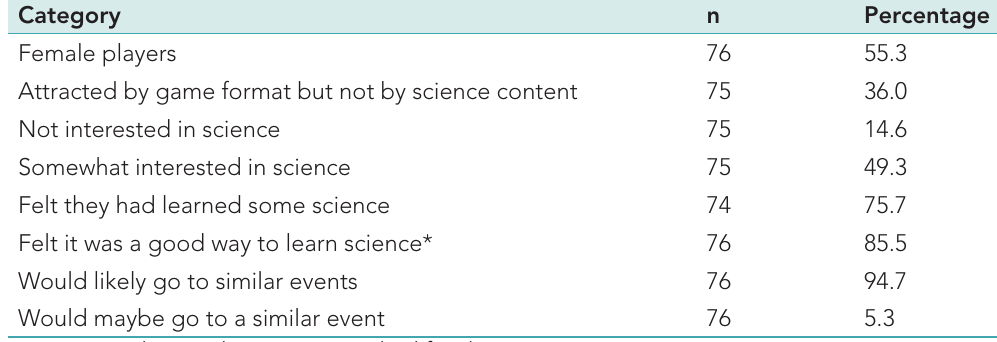
Table 2: Percentage of respondents filling each category of interest, and number